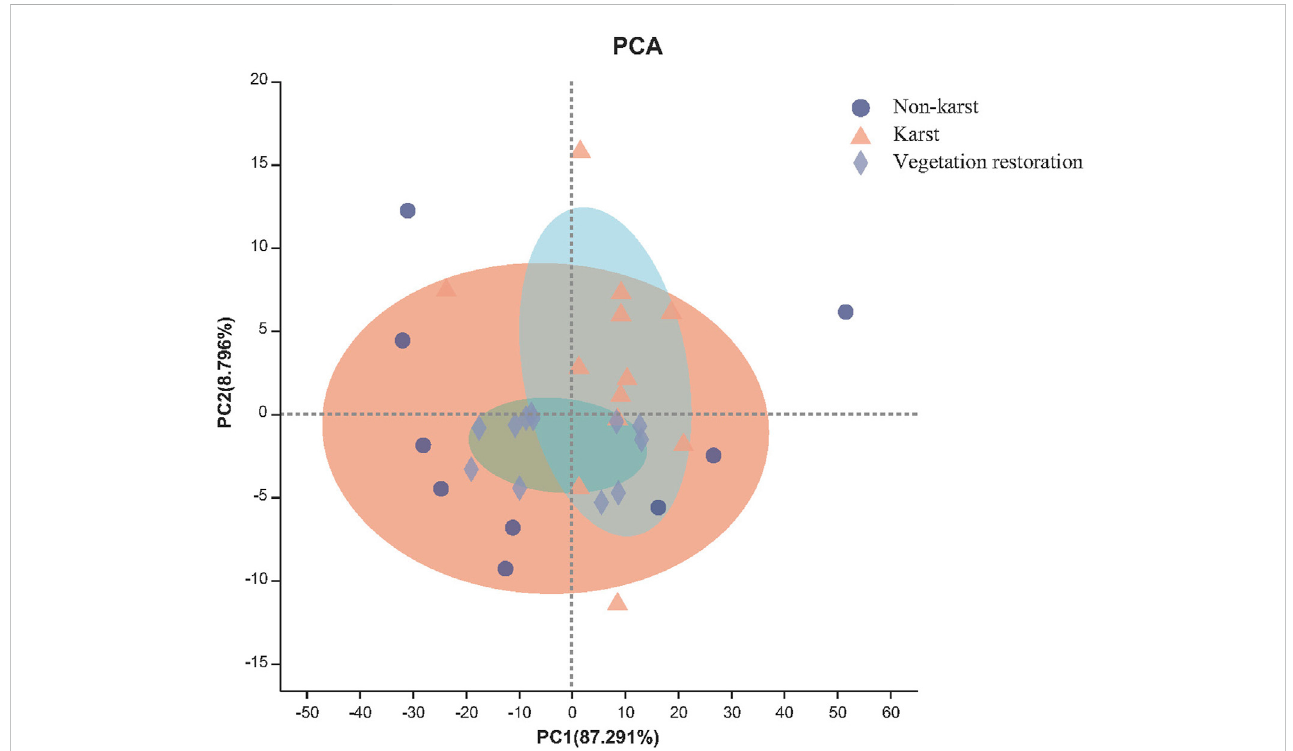
FIGURE 5 Principal coordinate analysis of soil physical and chemical properties. PC1: major coordinates of the largest possible explain data changes; PC2: the rest of the degree of change in the proportion of the largest main coordinate components.